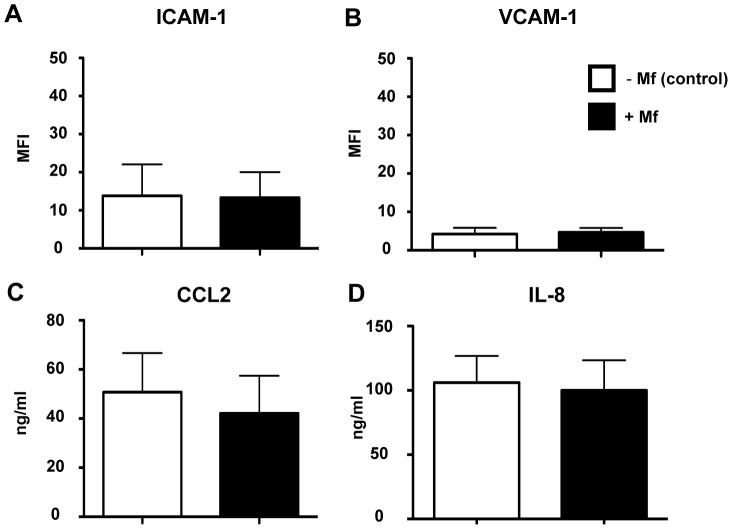
Live Mf presence does not alter HUVEC expression of key mediators of the tethering stage of monocyte and neutrophil extravasation.HUVEC were cultured with or without Mf for 24 hours prior to flow cytometry analysis and harvesting of supernatant. HUVEC surface expression of (a) ICAM-1 and (b) VCAM-1 was analysed by flow cytometry. Using ELISA, the supernatant was analysed for the protein secretion of (c) CCL2 and (d) IL-8. Data are shown as the mean and standard deviation per group of three independent experiments.